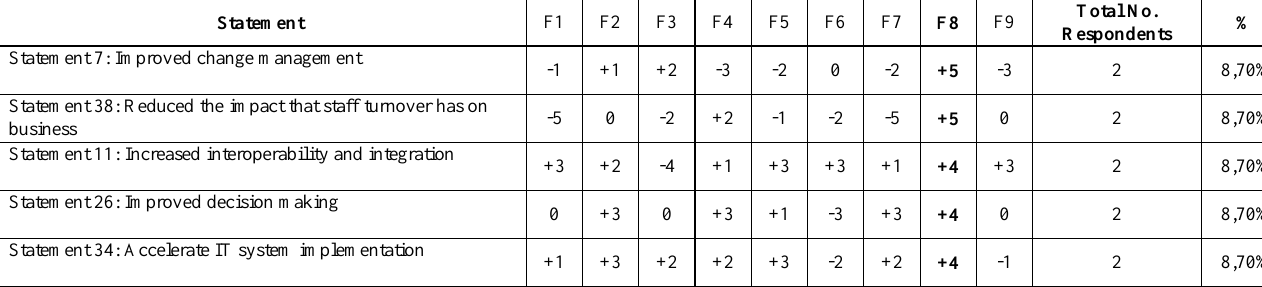
Table 12: Factor 8. Organisational change manager, key items